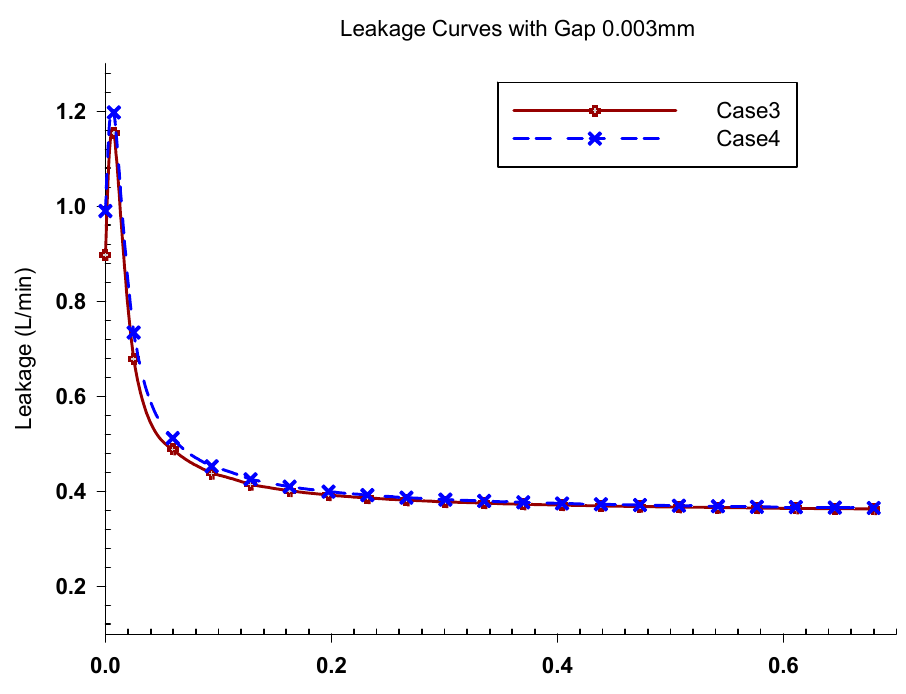
Figure 8. Dynamic curve of oil leakage rate with a clearance of 0.003mm .